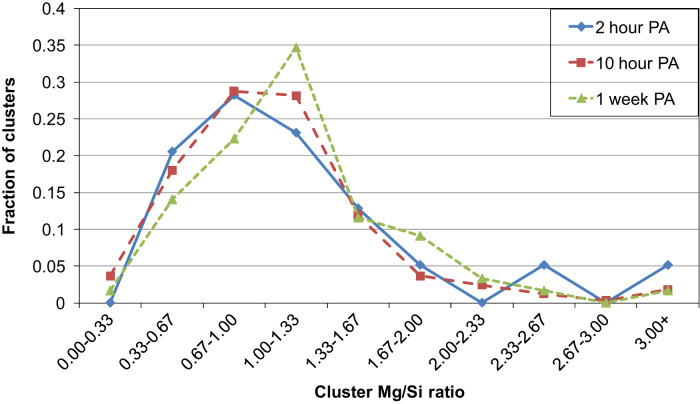
Fraction of clusters plotted against cluster Mg/Si ratio ranges after 2 or 10 h or 1 week PA as measured by LAR-3DAP.